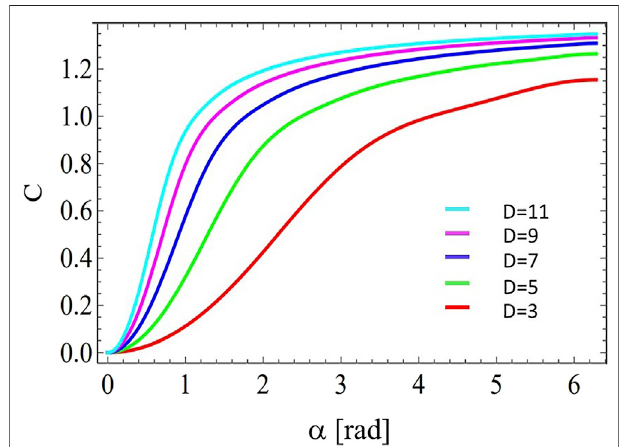
FIGURE 2 | Concurrence vs. angular aperture size for different OAM subpsace dimension ( D =2 ] +1)asindicatedin thelabel, considering asingle angular slit for both signal and idler photons ( M = N =1). Details are inthe